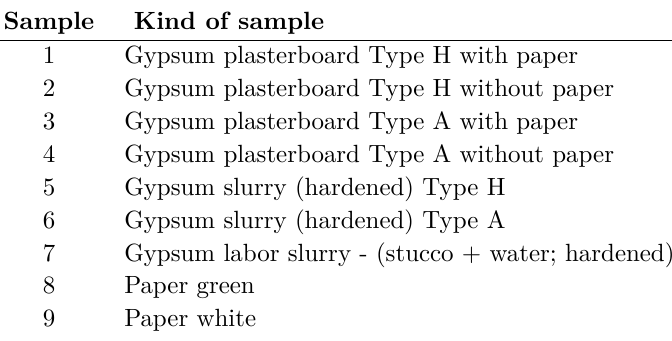
Table 2. Identification of the samples used to determine the resistance of the